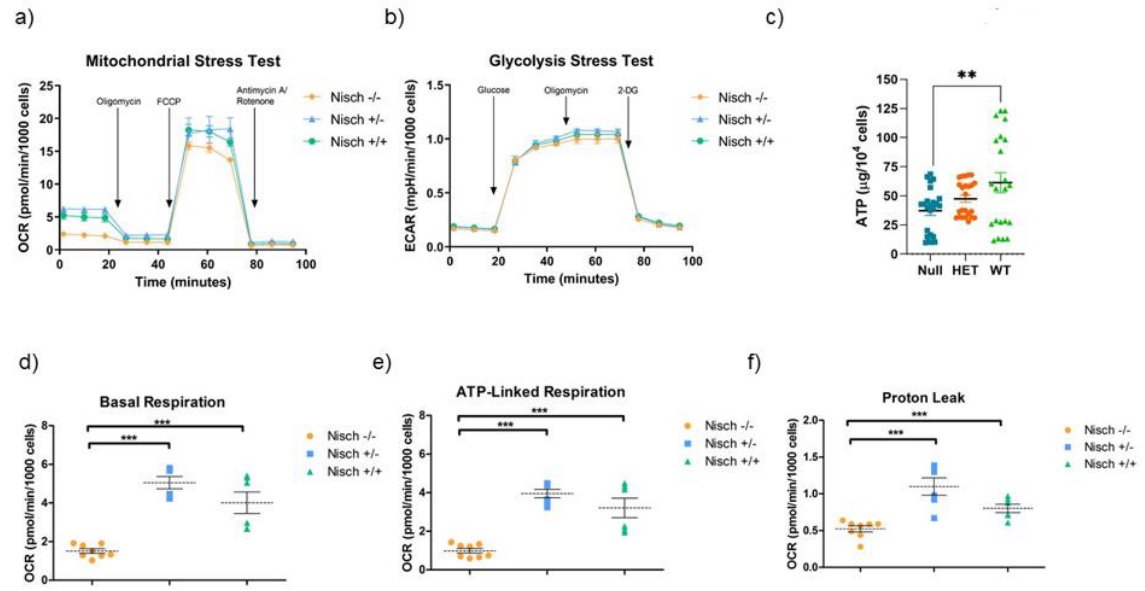
Figure 4. Real-time bioenergetic analysis reveals differences in mitochondrial activity. ( a ) Seahorse analysis was performed using the mitochondrial stress test conditions. Nisch − / − MEF cells showed a significant decrease in basal respiration, ATP-linked respiration, and proton leak; ( b ) glycolysis